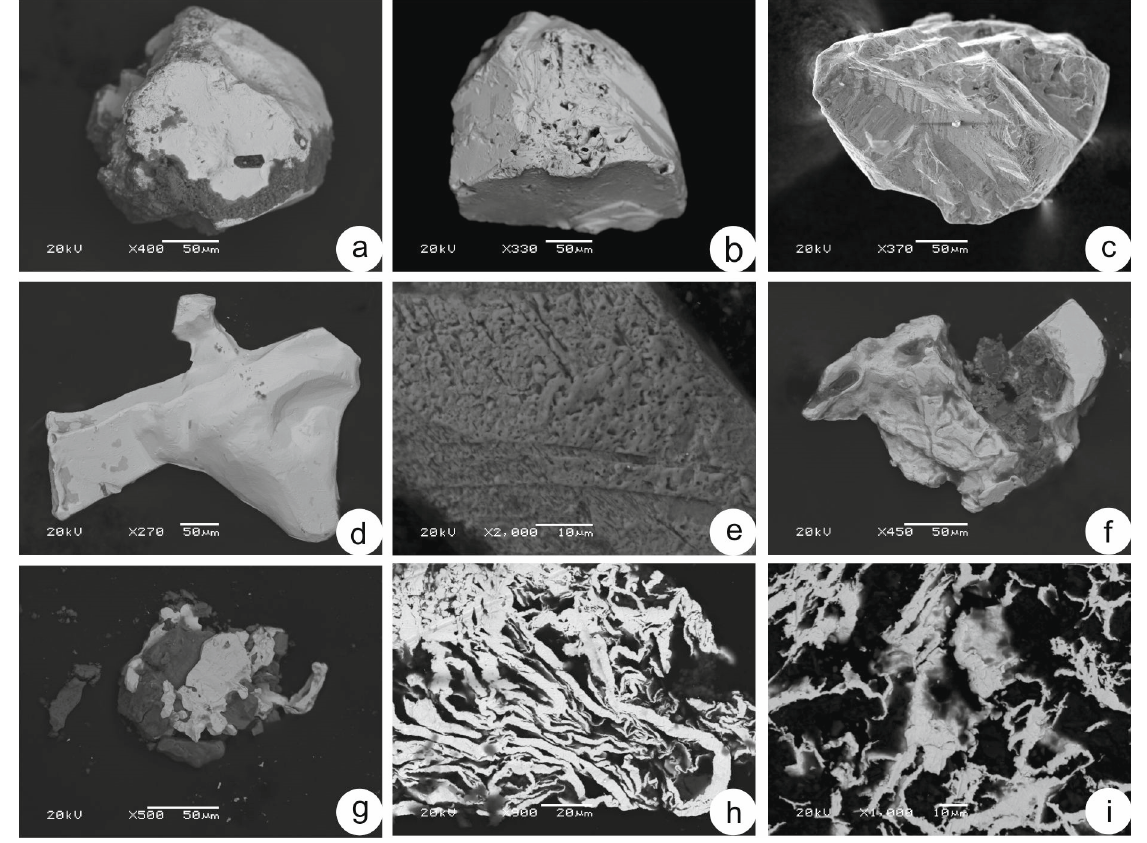
Figure 8. Morphology of supergene gold: ( a )—isometric crystal of octahedral appearance; ( b )—isometric crystal with the development of a combination of cube and octahedron shapes; ( c )—stepped structure of crystallomorphic druzoid gold; ( d )—clusters of crystals of prismatic and octahedral shapes; ( e )—prismatic with a microspongy structure; ( f )—hemi-idiomorphic gold; ( g )—shell dendritic; ( h )—lamellar-looped; ( i )—leafy dendritic.